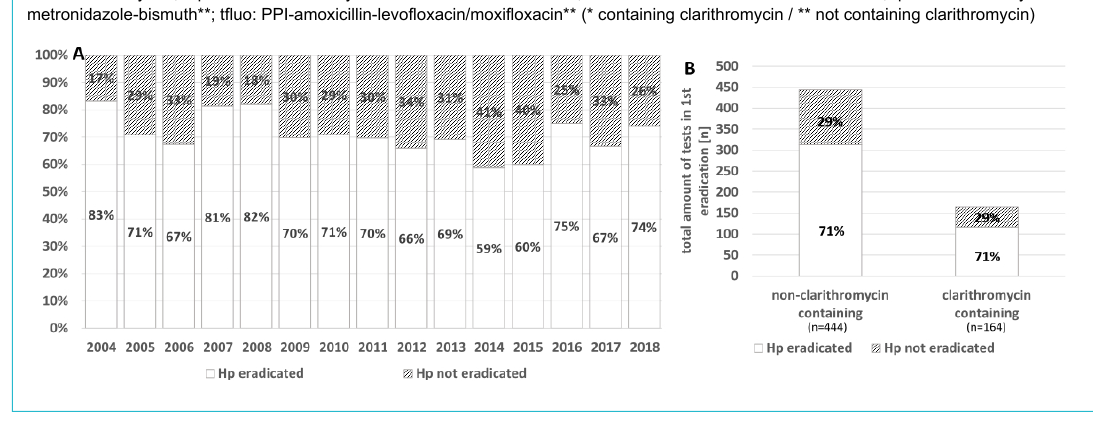
Figure 3: Success rate after different eradication regimens for Helicobacter pylori . (A) Overall success rate over the years after first eradica- tion therapy. (B) Eradication success after first-line therapies (2004–2018) categorised into clarithromycin-containing (french, italian, cquad) and non-clarithromycin-containing (ammet, quadt, tfluo). Hp: Helicobacter pylori ; french: PPI-amoxicillin-clarithromycin*; italian:PPI-metronida- zole-clarithromycin*; cquad: PPI-clarithromycin-amoxicillin-metronidazole*; ammet: PPI-amoxicillin-metronidazole**; quadt: PPI-tetracycline-